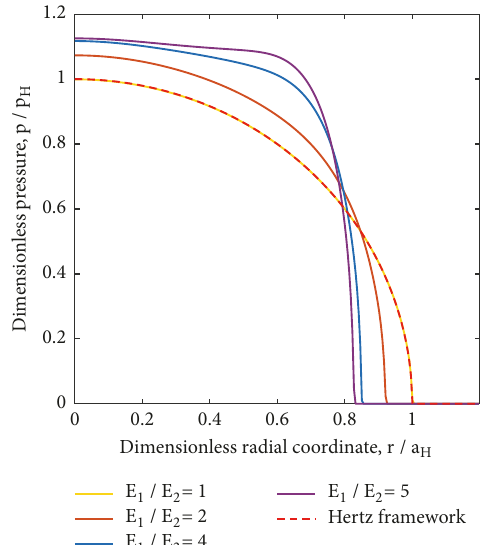
Figure 4: Spherical indentation of thin hard coatings, ℎ/𝑎 𝐻 = 0.25 .